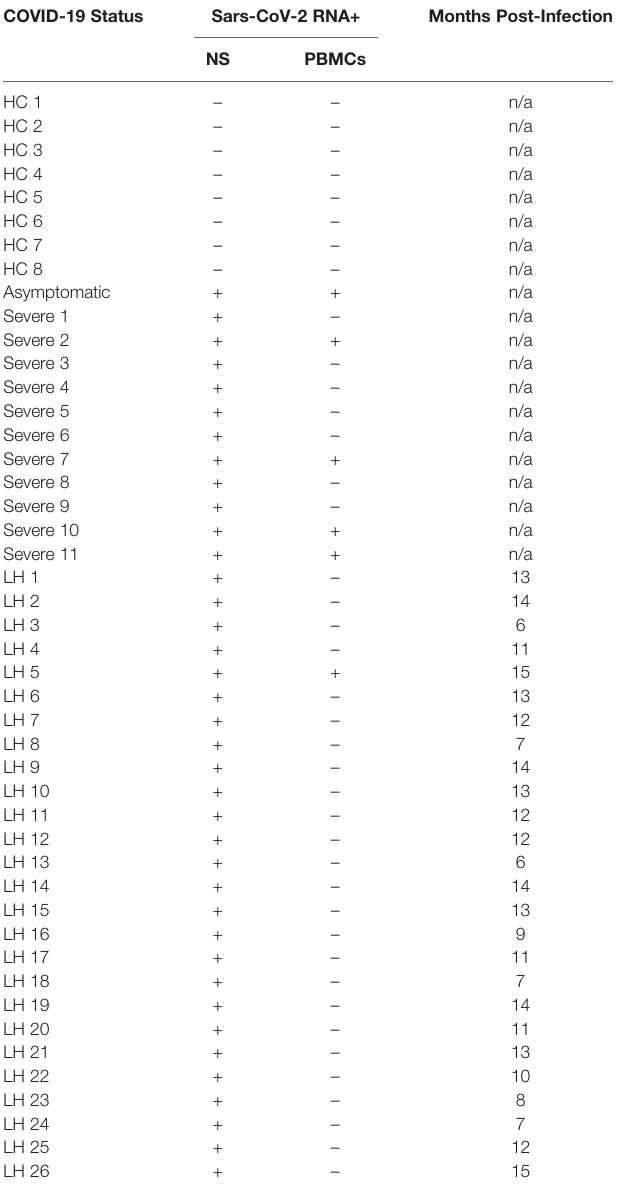
TABLE 1 | Molecular analysis and duration post-infection of study